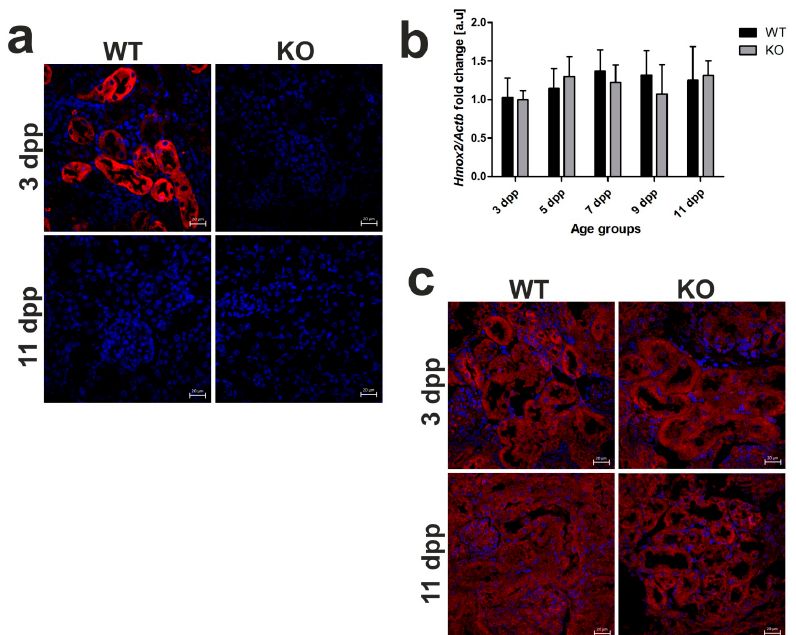
Figure 5. Heme oxygenase 1 (HO1) and heme oxygenase 2 (HO2) expression in the kidneys of wild-type and Hmox1 -deficient neonatal mice. ( a ) Immunofluorescence (IF) staining of HO1 (red channel) in the kidneys of 3 and 11 day old wild-type (WT) and Hmox1 knockout (KO) neonatal mice, analyzed by confocal microscopy. Cell nuclei were counterstained with DAPI (blue). Scale bars correspond to 20 µm. ( b ) RT-qPCR analysis of HO2 mRNA levels in the kidneys of WT and KO mouse neonates ranging from 3–11 days old. The graph presents relative HO2 transcript levels in arbitrary units (means ± SD, n = 5 per group; Student t -test, NS). ( c ) IF staining of HO2 (red channel) in the kidneys of 3 and 11 day old WT and KO neonatal mice, analyzed by confocal microscopy. Cell nuclei were counterstained with DAPI (blue). Scale bars correspond to 20 µm. dpp—days postpartum, NS—not significant.